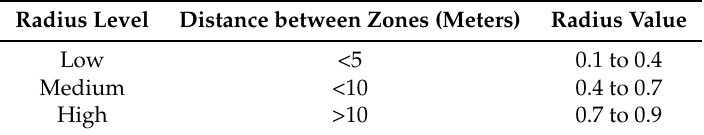
Table 2. Approximations of the influence radius levels depending on the distance between zones.